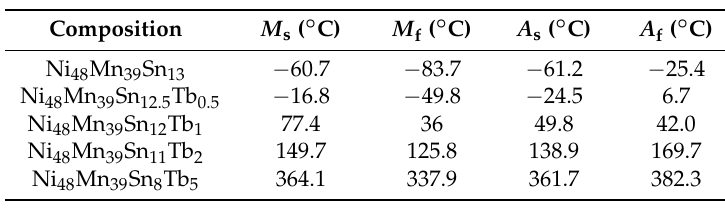
Figure 4. DSC curves of the Ni 48 Mn 39 Sn 13 − x Tb x alloys.